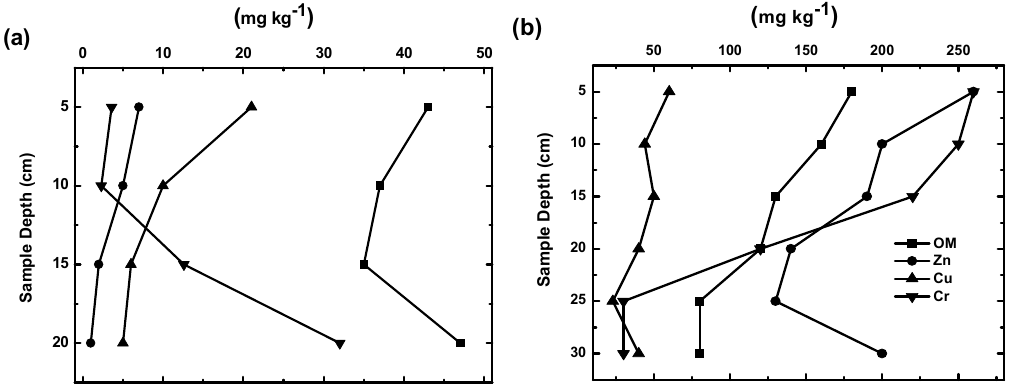
Figure 2. Heavy metals (Zn, Cu, and Cr) and organic matter content distribution with depth in DR ( a ) and SF ( b ) bulk sediment cores.